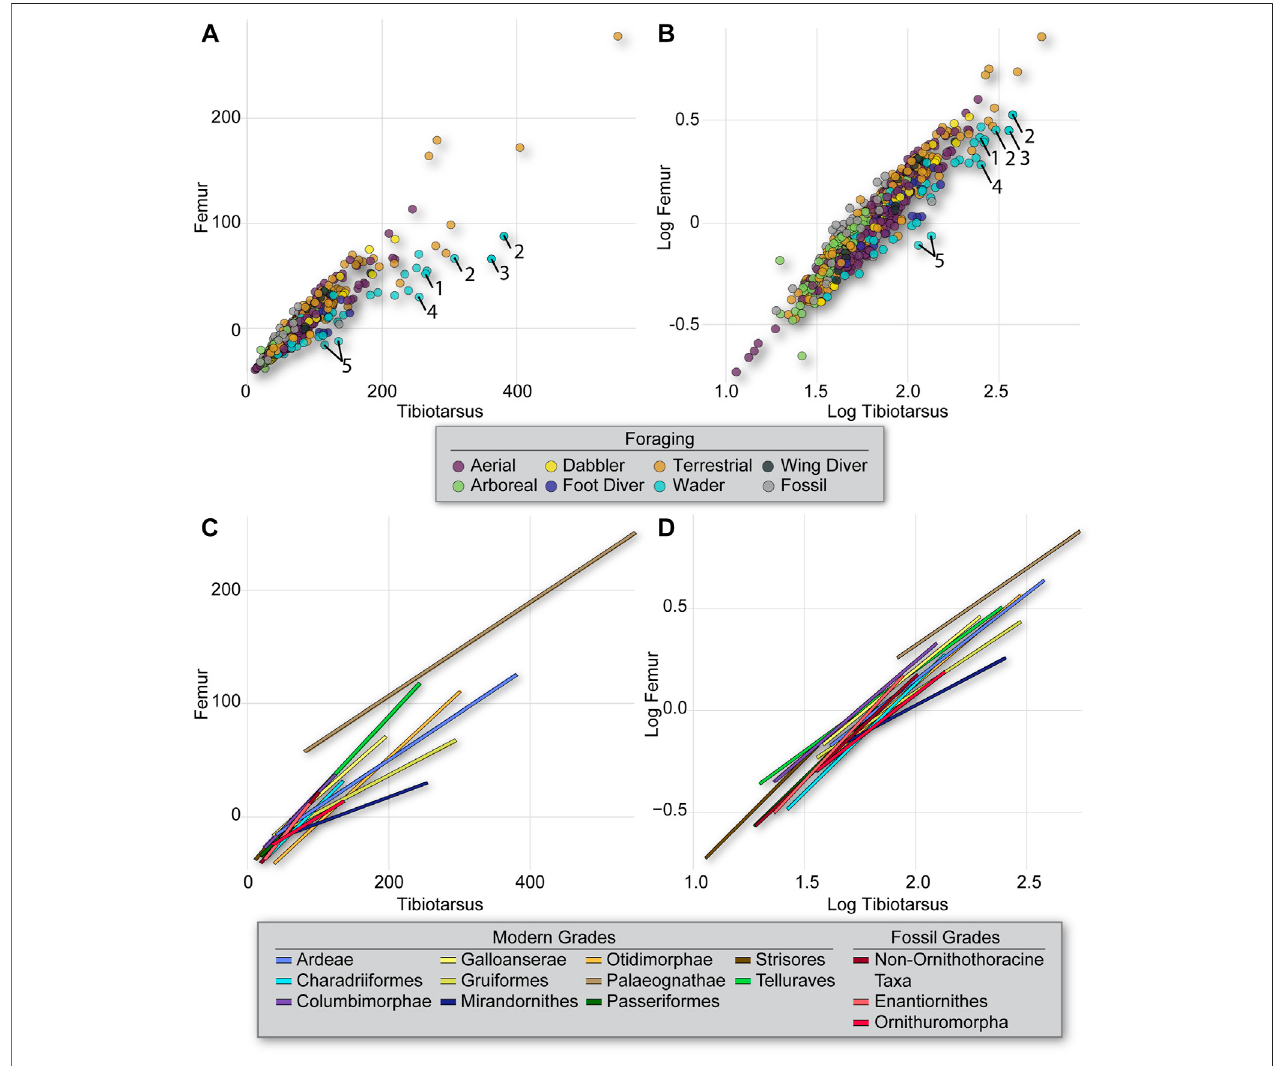
FIGURE6| Intralimbupper-legproportions(femurvs.tibiotarsus)fromallspecimenscodedbyforagingstrategy (A,B) andslopesforphylogeneticgroupings (C,D) resulting from the PGLS regression of the untransformed (A,C) and log 10 -transformed (B,D) data. As in Figure 5 , slope differences collapse when using log 10 - transformed data, confounding results. Taxa are numbered as follows in (A,B) : Storks – 1 Ciconia, 2 Leptoptilos, 3 Epihippiorhynchus ; Flamingo – 4 Phoeniconaias ; Stilt – 5 Himantopus.